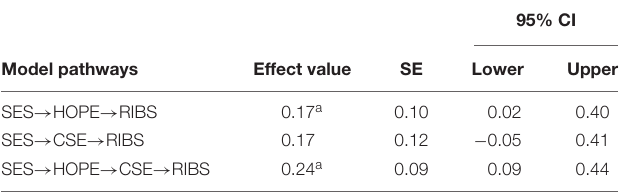
TABLE 2 | Indirect effects and confidence intervals of meditational analyses, controlling for